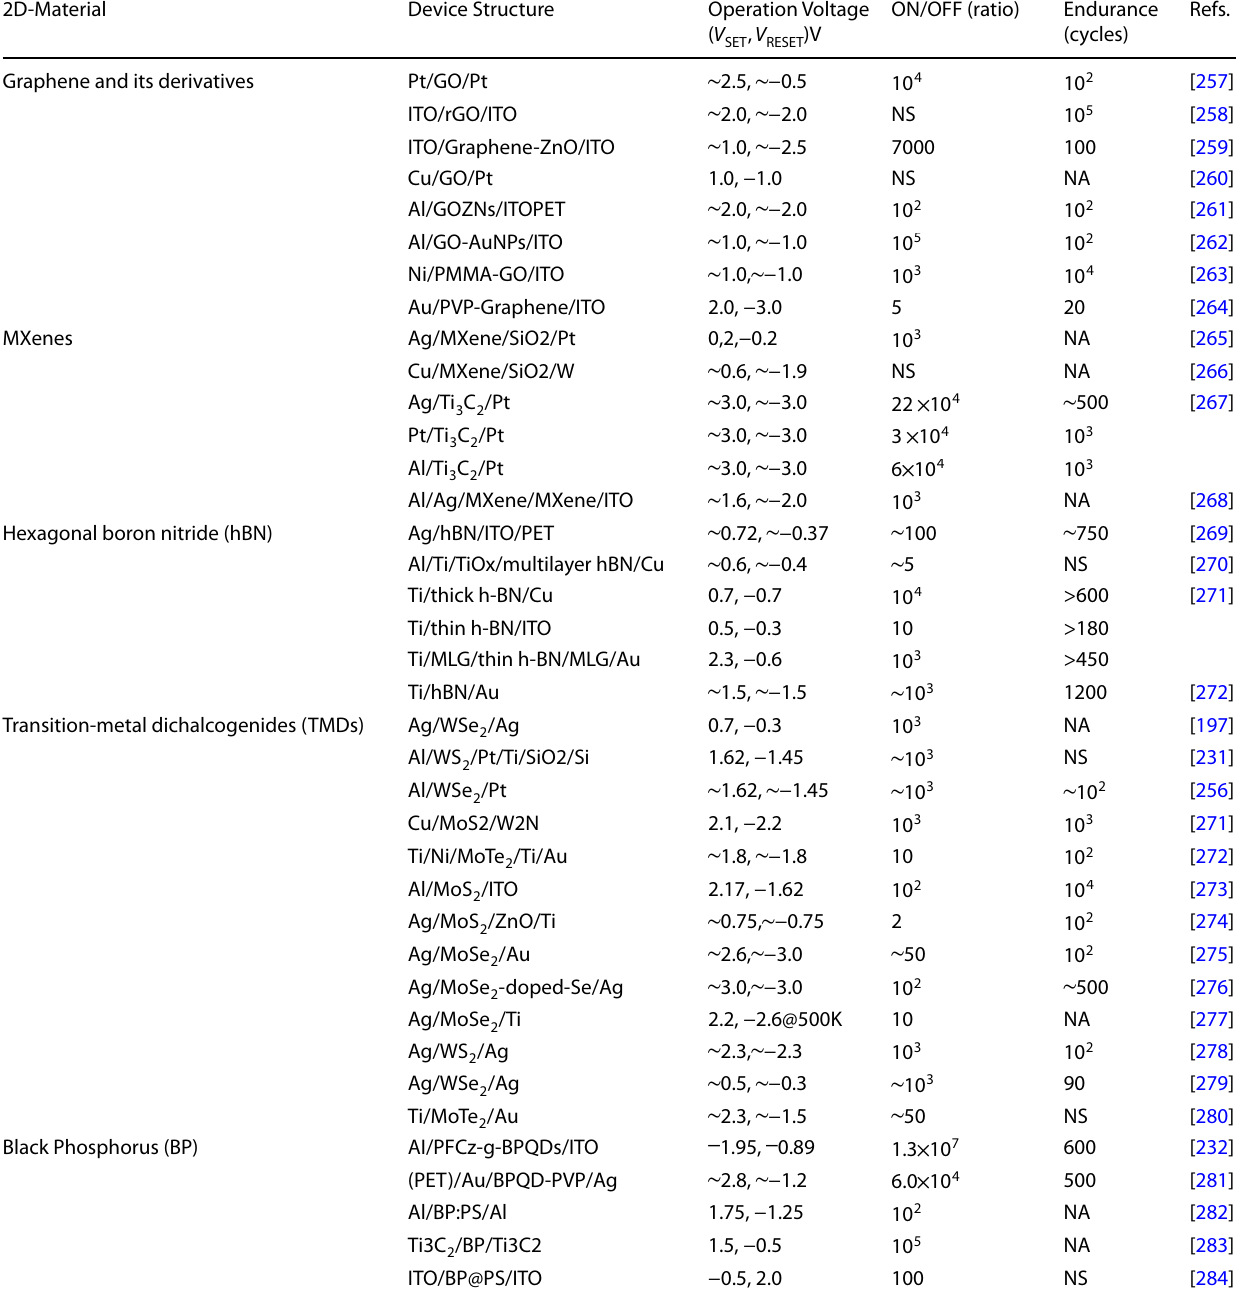
Table 3 Summary of the switching performance of 2D-Based RRAM devices [197, 231,